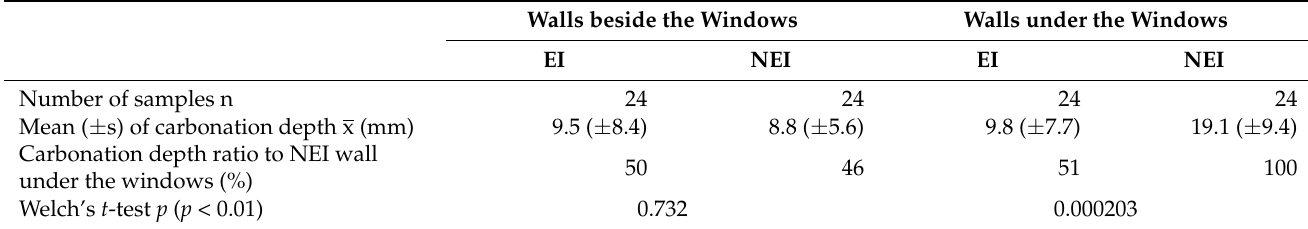
Table 3. Representative values and analysis and test results for each condition of Building A. Walls beside the Windows Walls under the